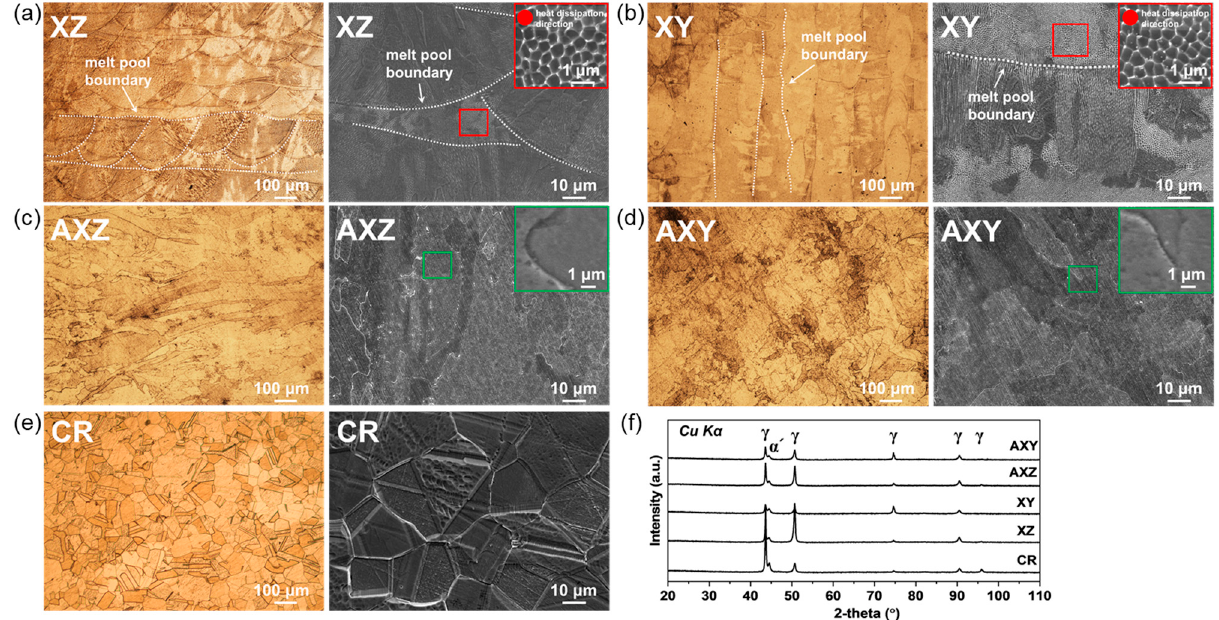
Figure 2. The microstructure images of each specimen: OM (left) and FE-SEM (right). Phase analysis of each specimen: ( a ) XZ, ( b ) XY, ( c ) AXZ, ( d ) AXY, ( e ) CR, ( f ) XRD pattern.